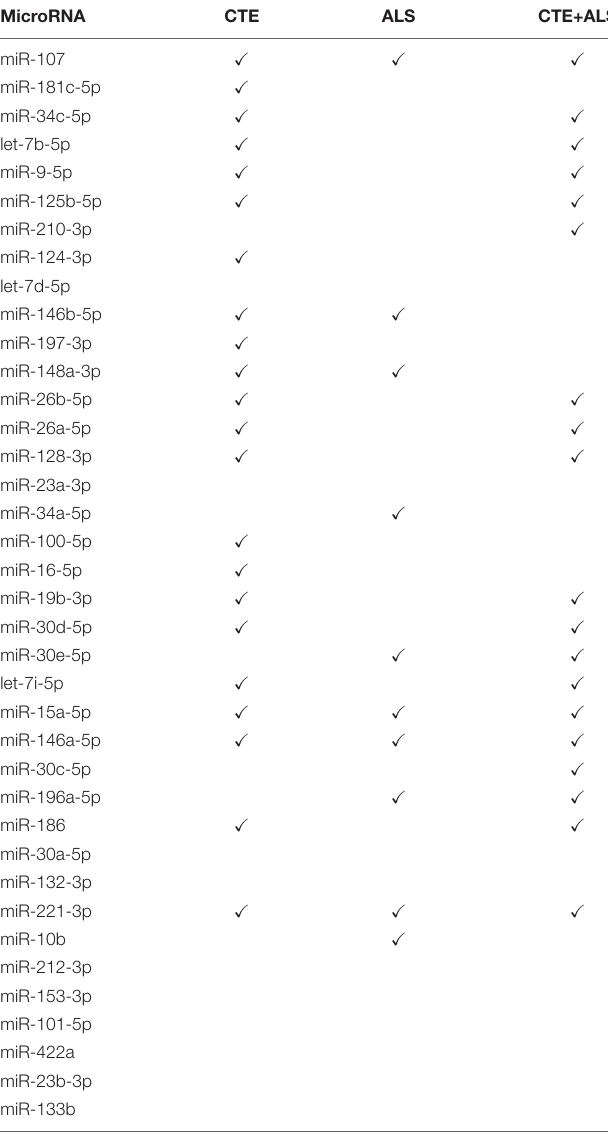
TABLE 3 | Upregulated miRNAs between control and pathology groups.